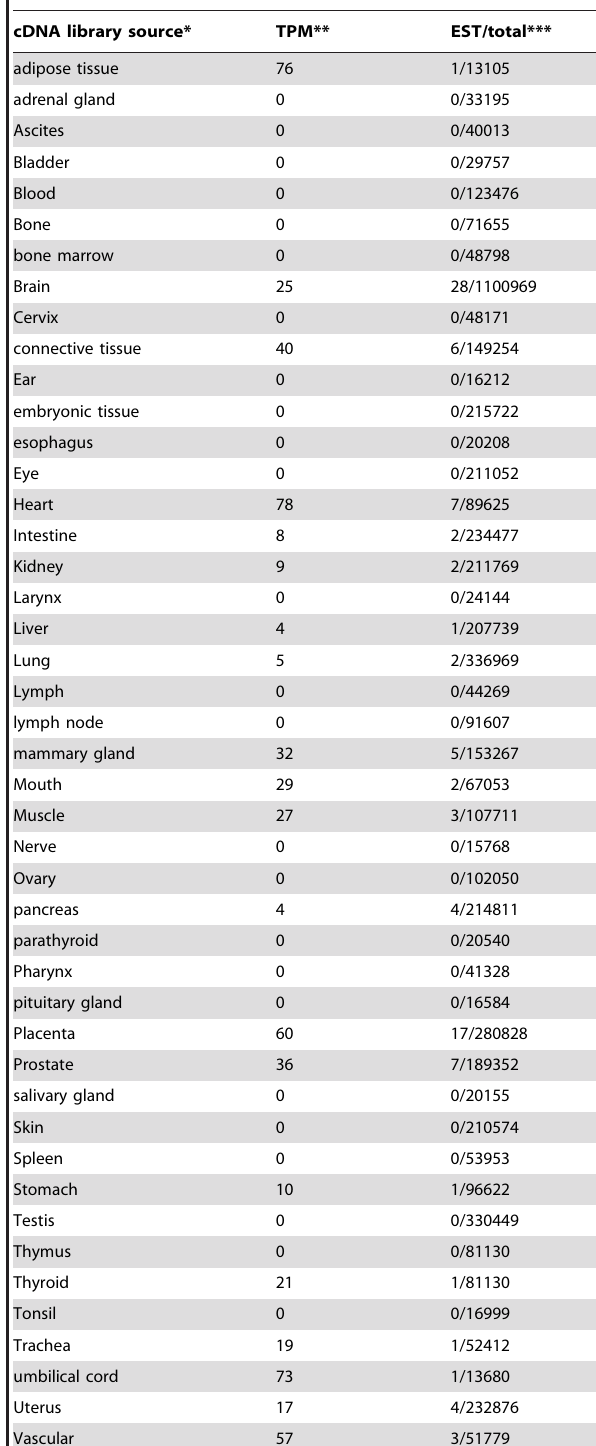
Table 2. Expressed sequenced tag (EST) profiles showing DIA1 gene expression in human tissues.